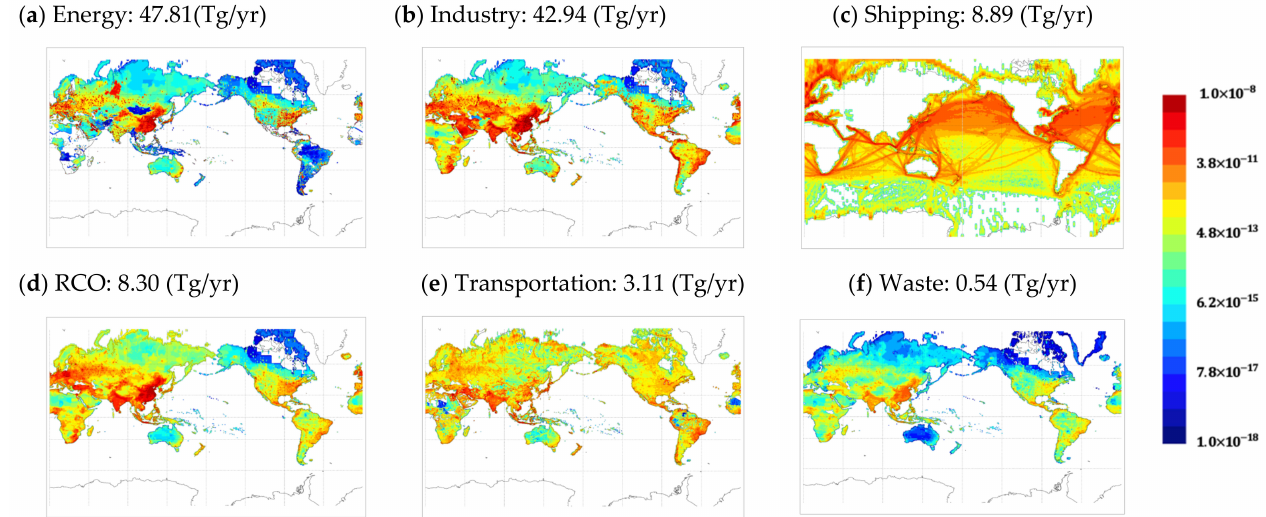
Figure 3. The global distributions of annual SO 2 sectoral emissions (Gg/m 2 /yr) in CEDS 2014 (sectoral emission names ( a – f ) and the global annual sectoral emissions (Tg/yr) are shown above the figures).